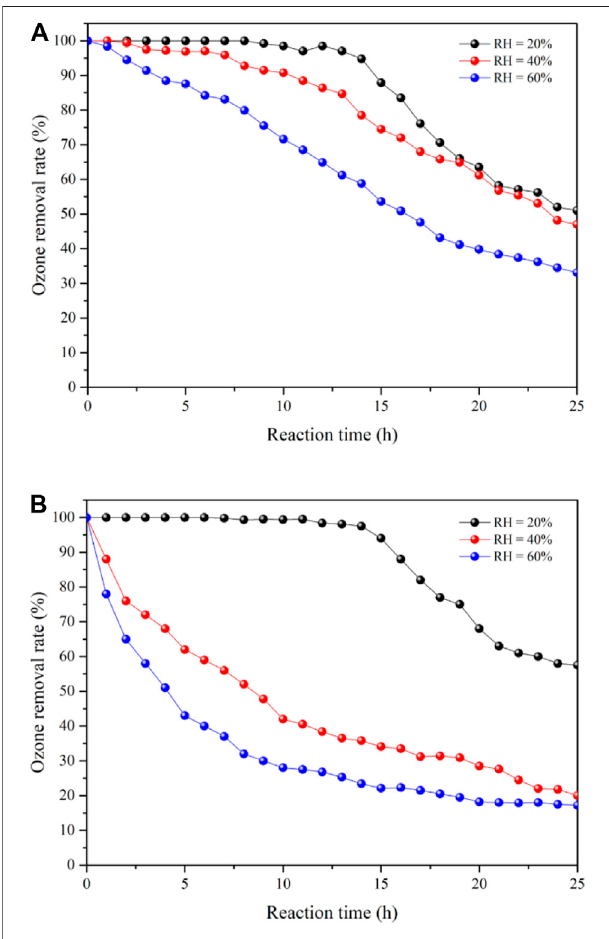
FIGURE 5 | Ozone removal rate of 25Co 3 O 4 @SiO 2 (A) and Co 3 O 4 /SiO 2 (B) . Temperature (cid:1) 25 ° C; relative humidity (RH) (cid:1) 20, 40, and